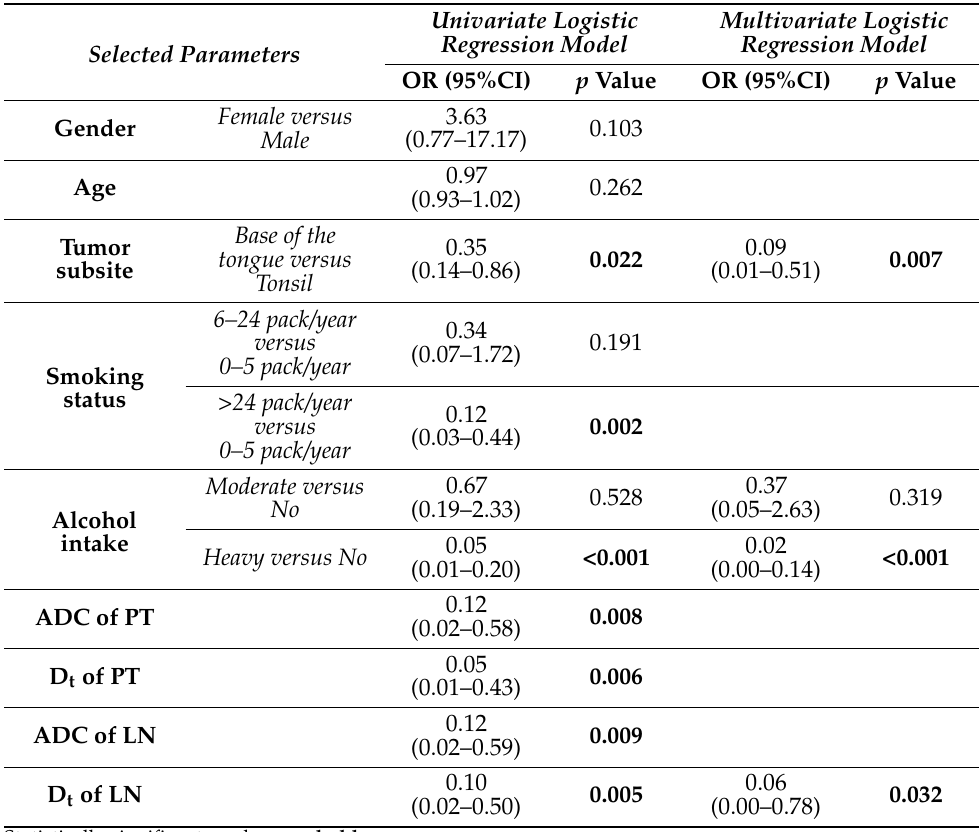
Table 5. Uni- and multivariate logistic regression models of factors associated with HPV status. Selected Parameters